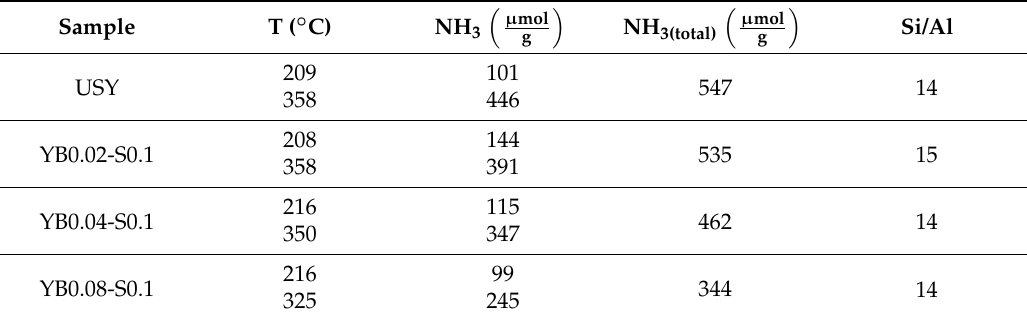
Table 4. Quantification of the total acidity of the zeolites.